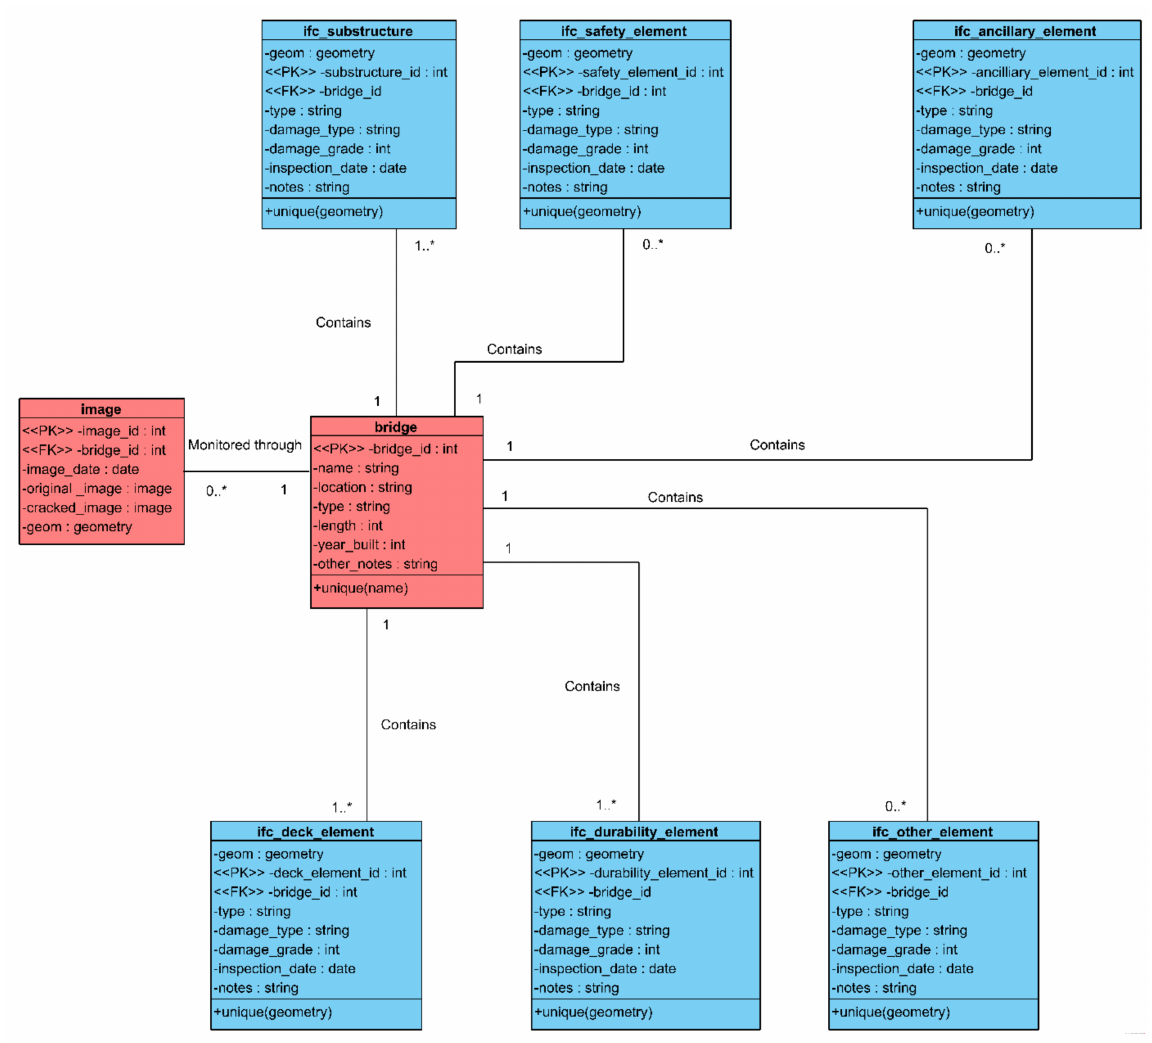
Figure 8. UML Diagram of Bridge Inspection Schema.